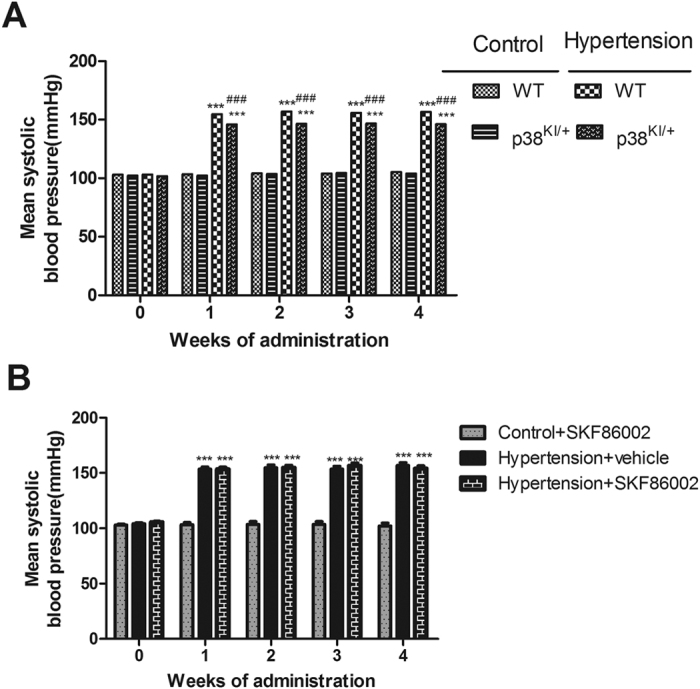
Mean systolic blood pressure during chronic angiotensin II or saline (Ctrl) perfusions.(A) in vivo experiment (n = 17–20, ***p < 0.001 vs control WT and p38KI/+ group, ###p < 0.001 vs HT group). (B) in vitro experiment, (n = 5, ***p < 0.001 vs control + vehicle group).